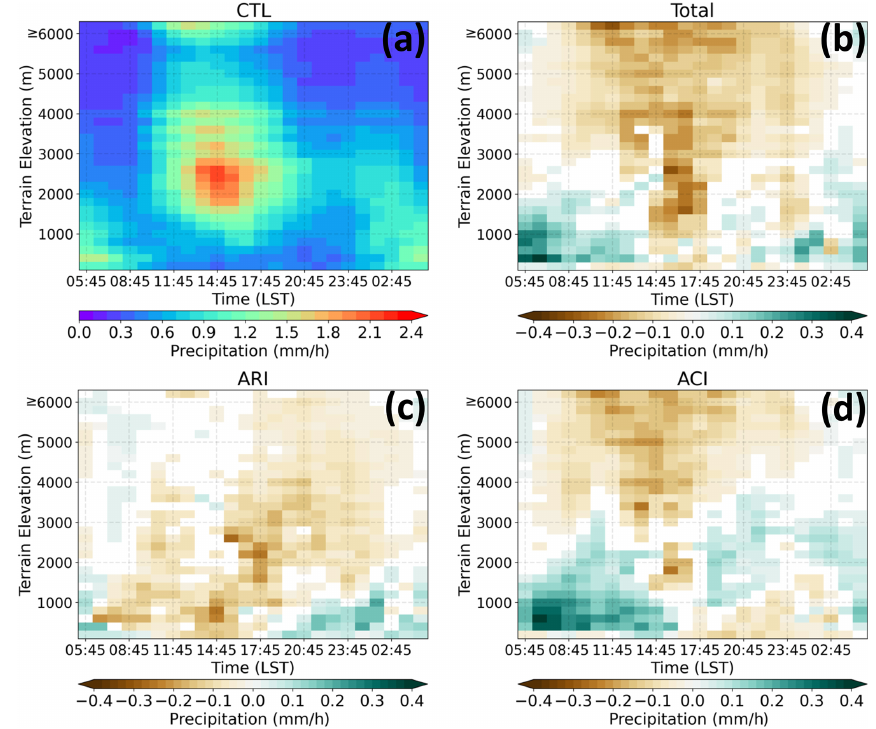
Figure 8. Elevation-dependent precipitation for (a) CTL, (b) aerosol effect (CTL–CLEAN), (c) ARI effect (CTL–NoARI), and (d) ACI effect (NoARI–CLEAN) and their diurnal variability. Only the differences that are significant at the 90% confidence level based on the Student t test are